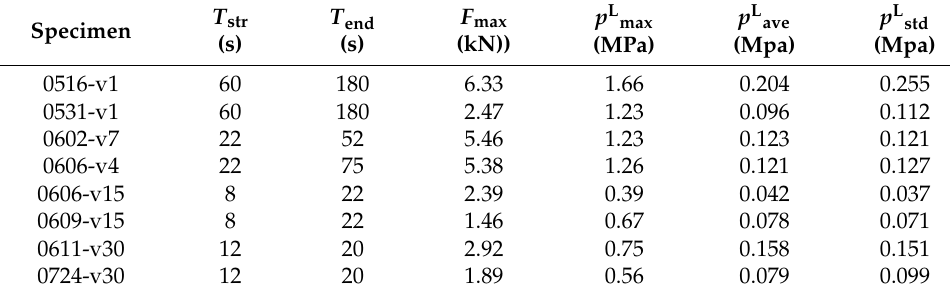
Figure 5. Selected global ice force curves. ( a ) V load is 1 mm/s, ( b ) V load is 4 mm/s and 7 mm/s, ( c ) V load is 15 mm/s, ( d ) V load is 30 mm/s. Table 2. Measured global ice force and local ice pressure